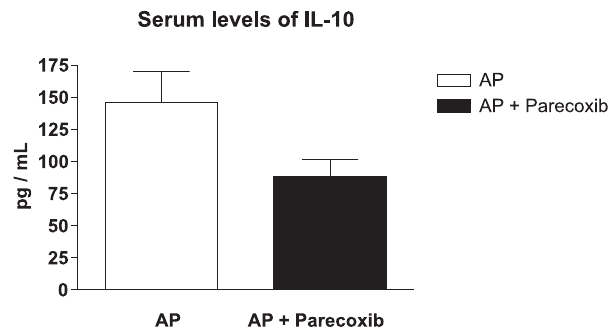
Figure 3 . Effect of Cox-2 inhibition on serum levels of IL-10, evaluated by an ELISA method, showing lower level in parecoxib-treated rats ( AP - Mean ±SEM = 146.3 ± 23.48, n=8 and AP + Parecoxib - Mean ±SEM = 88.43 ± 12.93, n=14 with p = 0.0288).